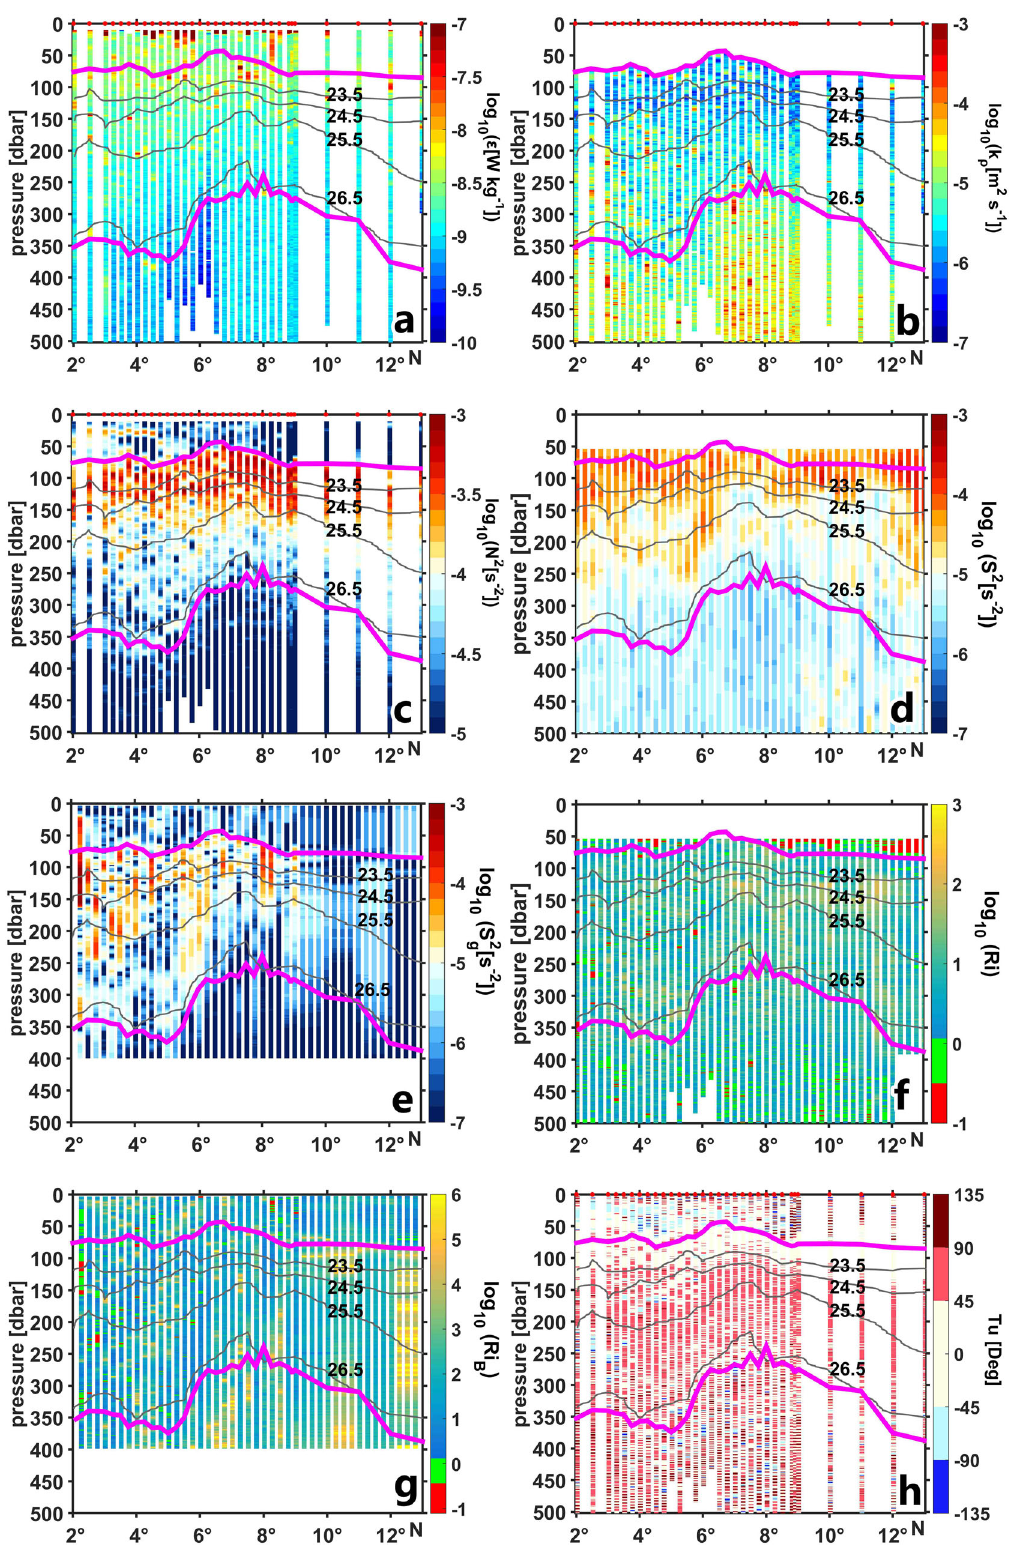
Fig. 2 Latitude-depth sections of the microstructure pro fi ler measurements along 130°E during the 2017 cruise. a Observed turbulence kinetic energy dissipation rate ε (unit in W kg − 1 ), b diapycnal diffusivity κ ρ (m 2 s − 1 ), c squared buoyancy frequency N 2 (s − 2 ), d the total vertical shear squared S 2 (s − 2 ), e (s − 2 ), f the gradient Richardson number R i , g the balanced Richardson number Ri B , and h the Turner angle (Tu). the geostrophic vertical shear squared S 2 g Thick purple lines are the upper and lower boundary of the thermocline, respectively. Gray lines are the isopycnals, and red dots in the top axis are locations of the microstructure pro fi ler